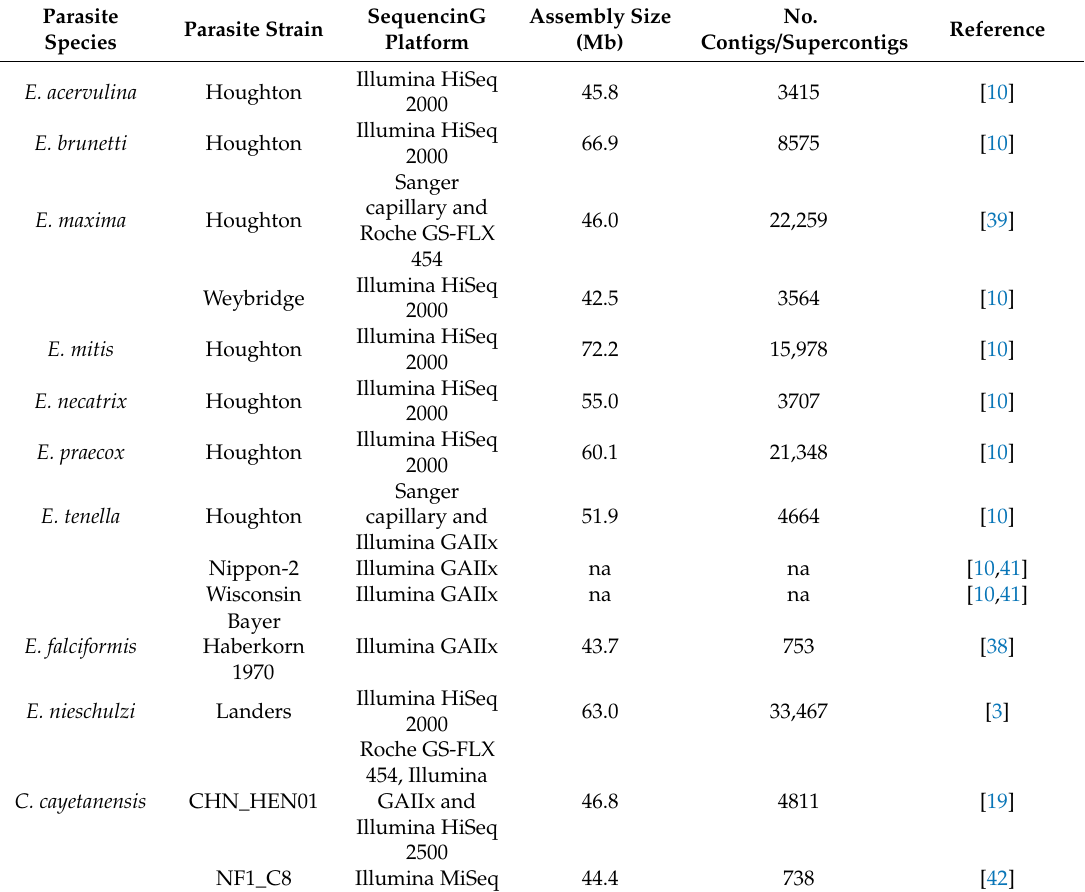
Table 1. A summary of genome sequence assemblies available for Eimeriidae family